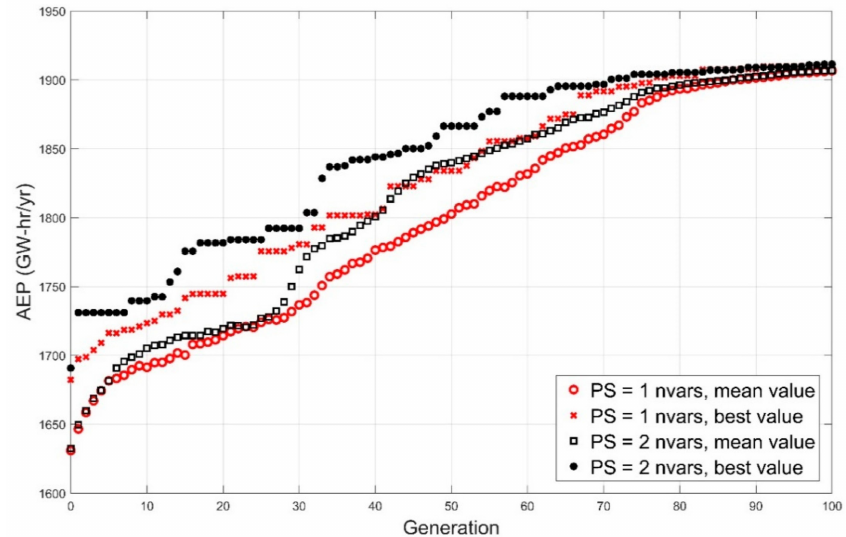
Figure 7. Convergence history for one of the investigated cases over 100 generations for PS = 1 nvars and PS = 2